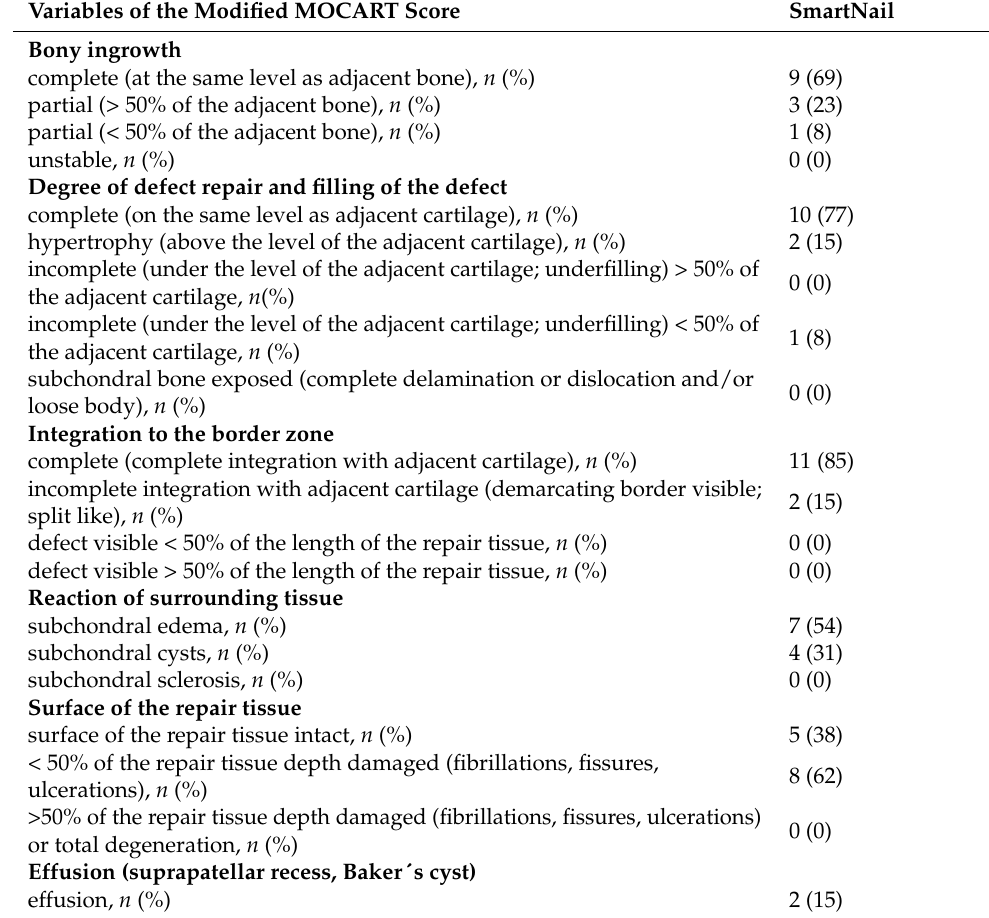
Table 5. Variables of the modified MOCART